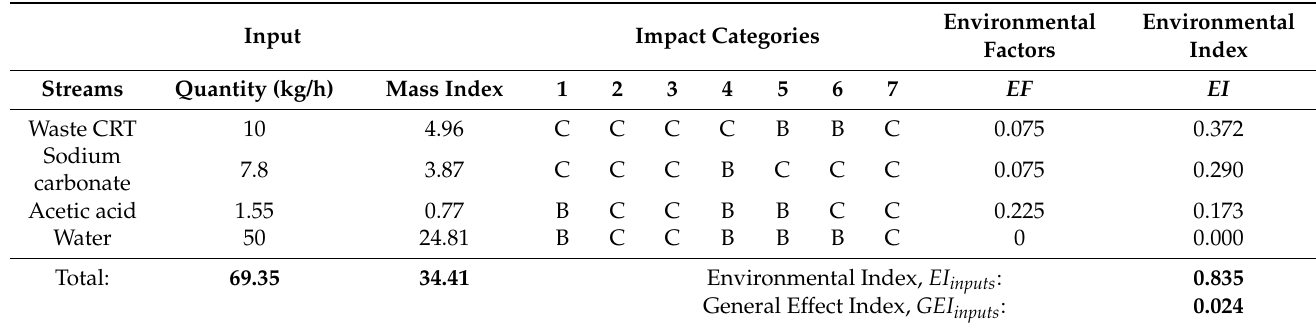
Table 3. Input impact assessment.